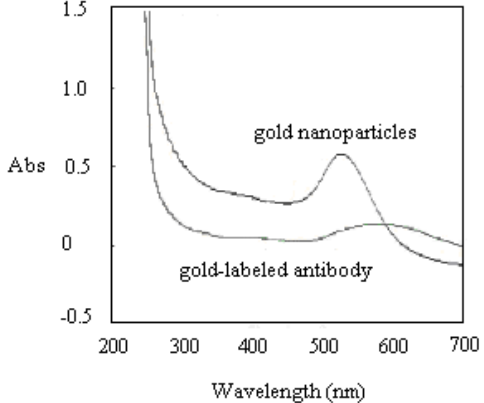
Figure 2. UV/VIS analysis of the gold-labeled antibody. The peak became flattened and the peak wavelength shifted from 524 nm to 560 nm, after the mouse anti-digoxigenin antibody was labeled with the nano-gold particles.